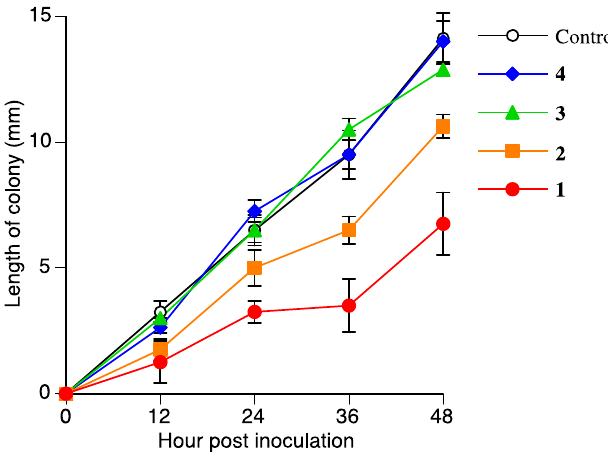
Figure 7. Antifungal activities of 1 , 2 , 3 , and 4 (300 µmol/L) against Rhizoctonia solani mycelium growth. Values are presented as the mean ± SD ( n = 4). Table 2. Inhibitory activity of 1 , 2 , 3 , and 4 on Rhizoctonia solani mycelium growth after 48 h of incubation.